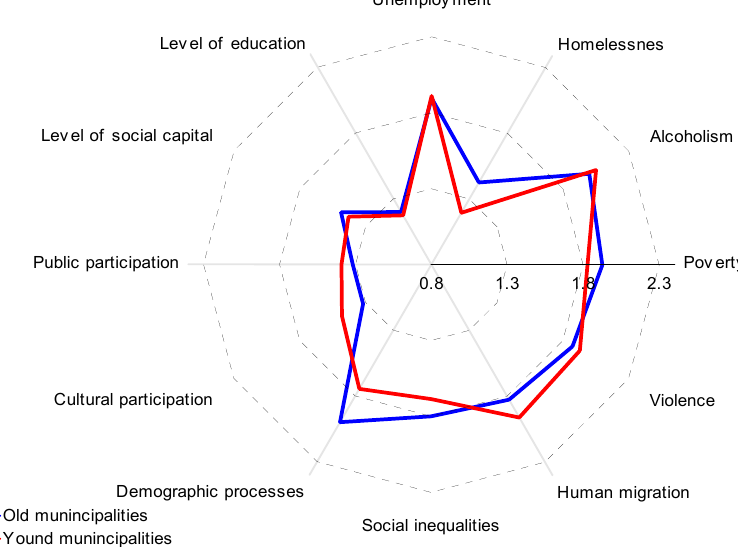
Figure 2. The persistence of selected social issues in the analysed municipalities depending on the demographic structure.